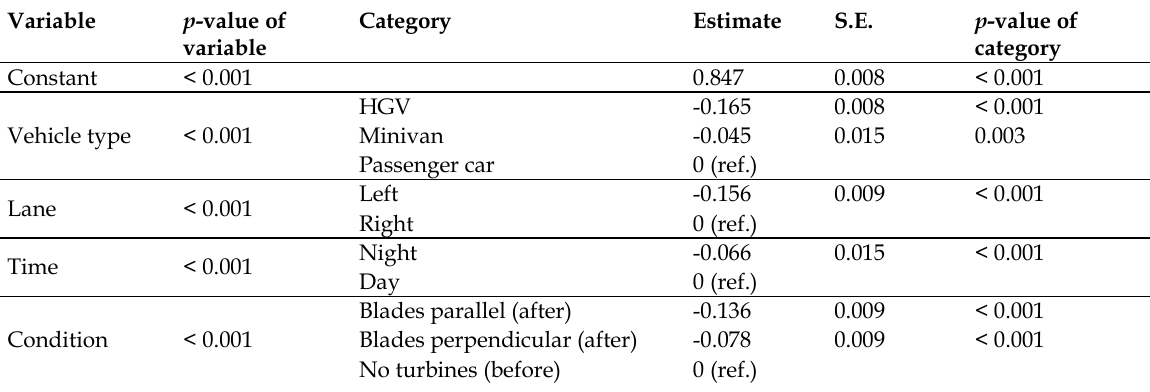
Table 2. Regression model lateral